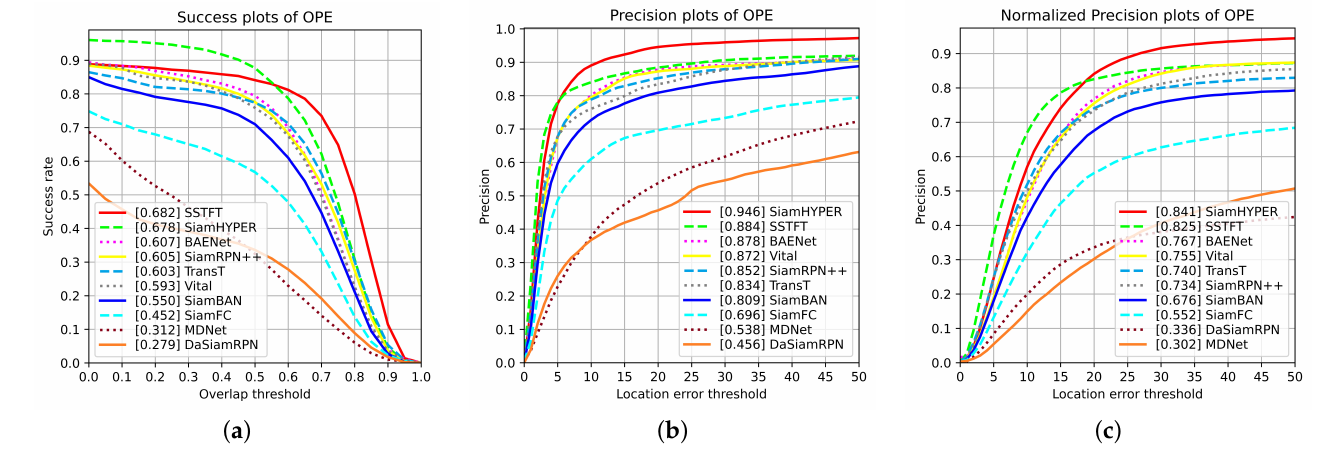
Figure 4. Comparisons with deep learning trackers on